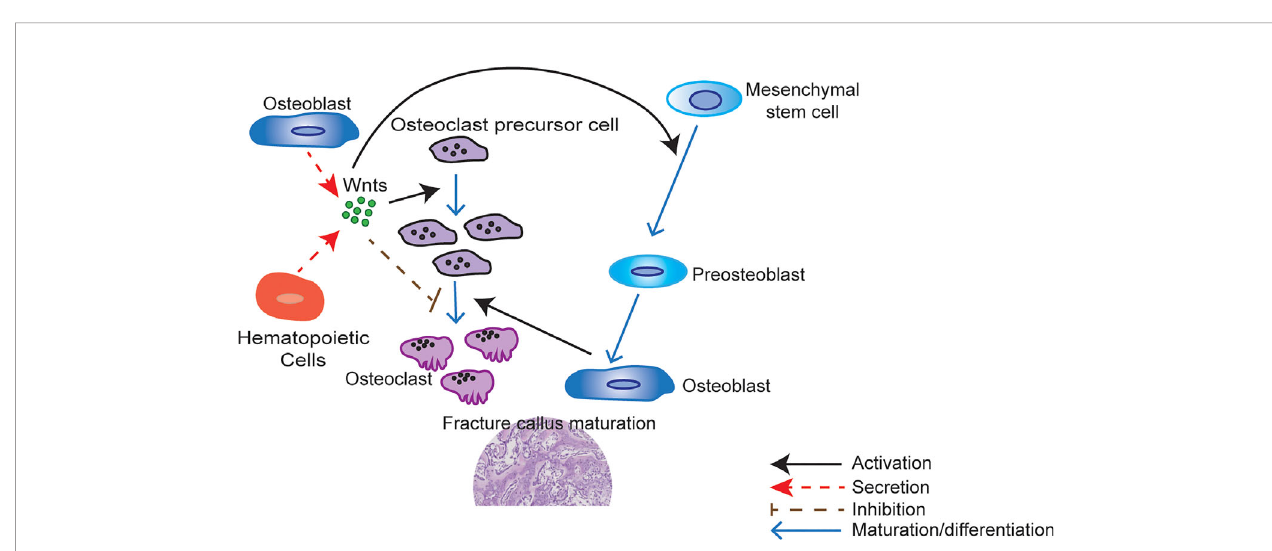
FIGURE 2 | Wnts modulate fracture callus maturation. Hematopoietic and other cells within the bone microenvironment secrete Wnts. Wnt upregulation activates osteoclastic precursor cell proliferation but inhibits osteoclastic precursor cell maturation to osteoclast. Carefully regulated Wnt activity is therefore required for the correct number of mature osteoclasts to develop during fracture healing. Wnts are also responsible for the activation of mesenchymal stem cell differentiation to osteoblasts. These mature osteoblasts are responsible for the formation of woven bone. Osteoclasts also play a key role in callus maturation by resorption of cartilage during callus remodeling. A quantitative shortfall in the secreted Wnts may therefore result in a less mature callus with more cartilage and less woven bone by inhibiting the proliferation of osteoclast precursor cells.